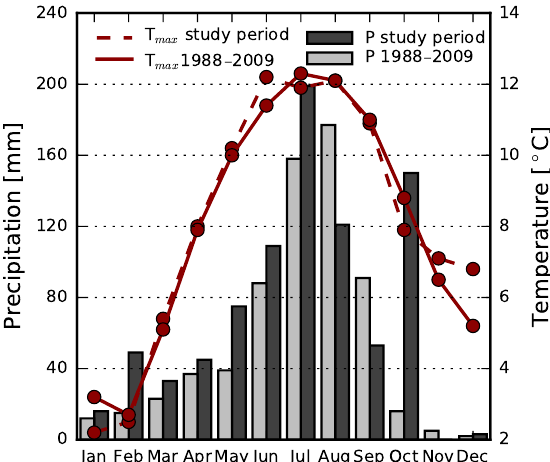
Figure 2. Comparison of maximum temperature ( T max ) and cumu- lative monthly precipitation ( P ) for the study period (January 2013– September 2014) and the 1988–2009 time series (based on measure- ments in Kyangjin). The average yearly cumulative precipitation is 853 and 663mm for the study period and the 1988–2009 time series respectively.